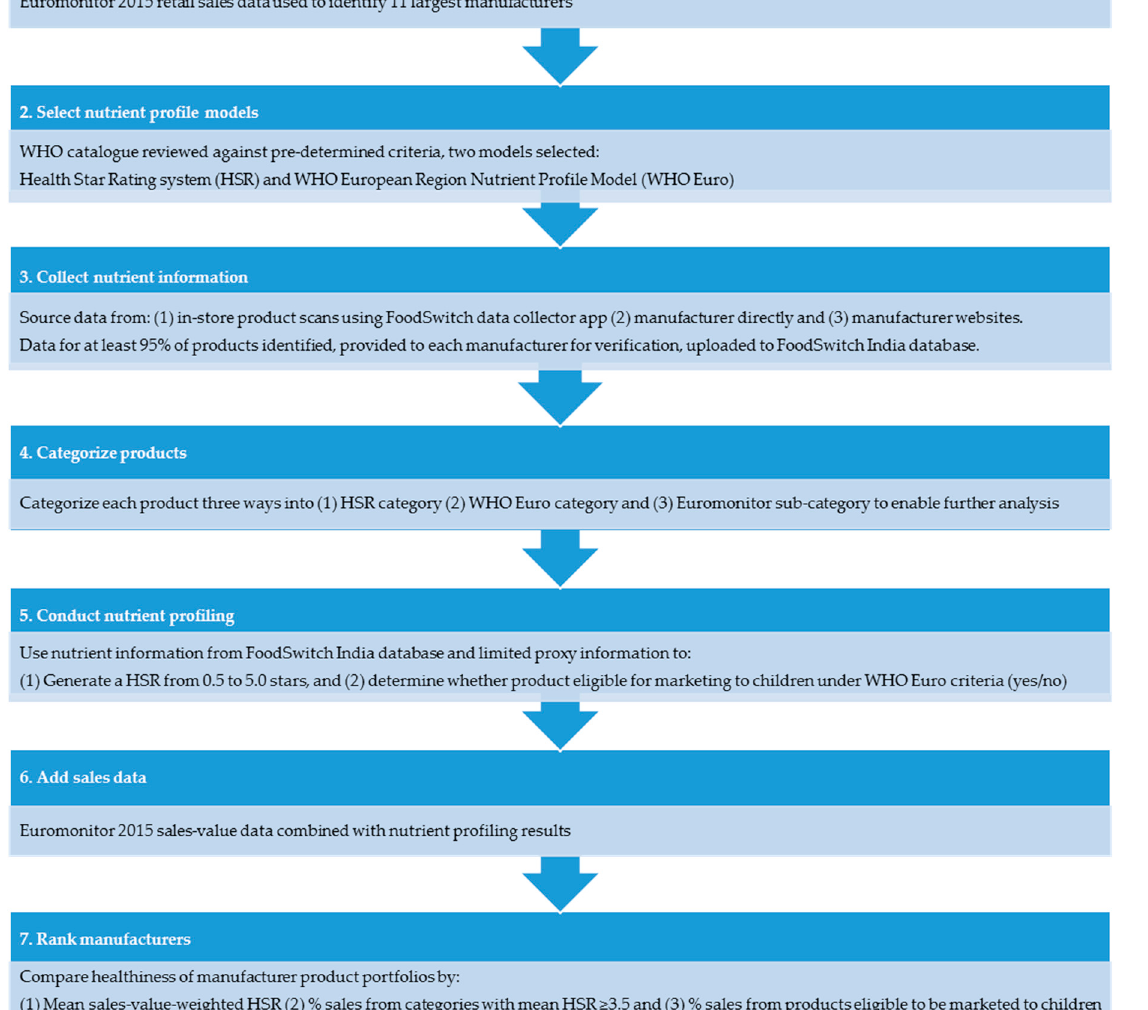
Figure 1. Methods and data sources.